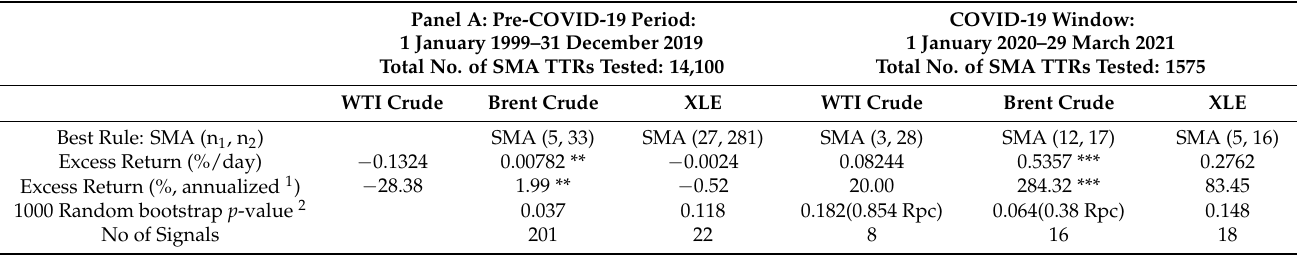
Table 3. The best TTRs’ parameters and performance with no transaction costs and BH returns as